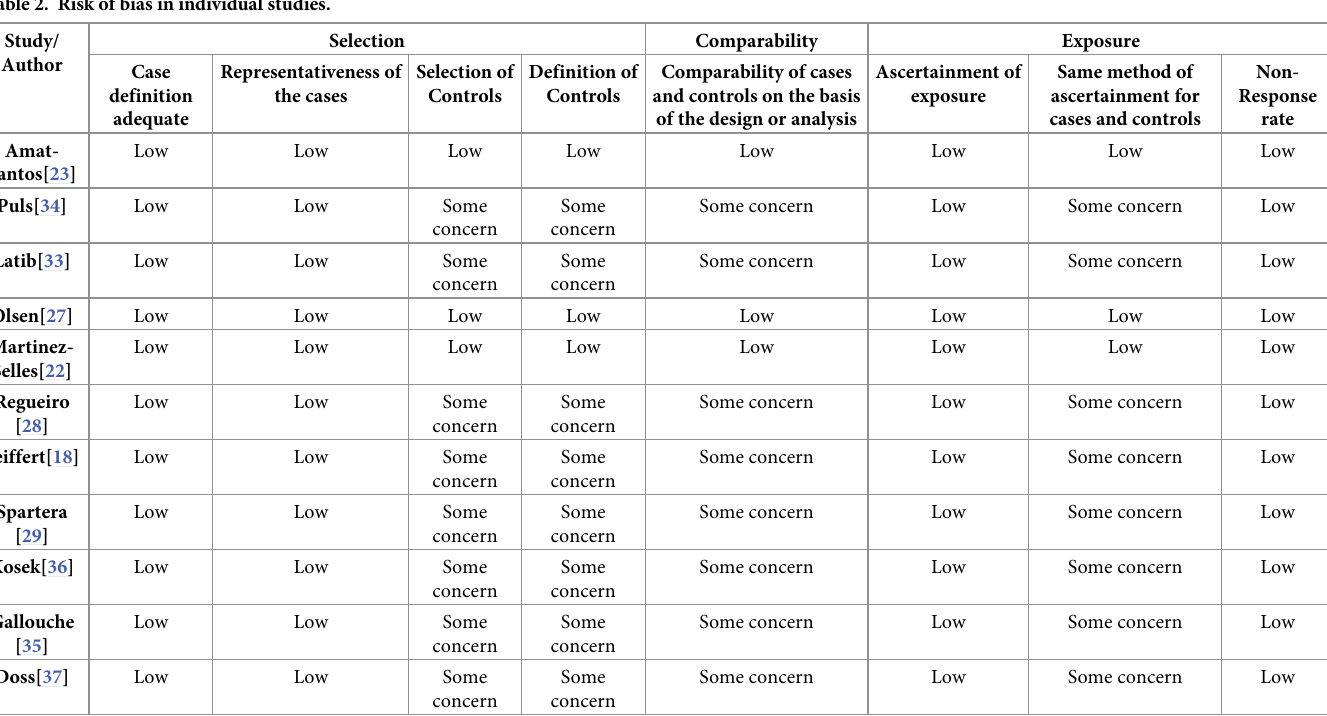
Table 2. Risk of bias in individual